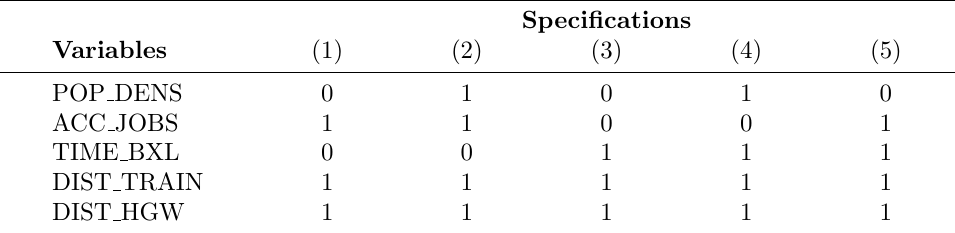
Table 3: Specifications of the DCM estimated for Monocentric and Polycentric case study (1 if the variable is included in the specification, 0